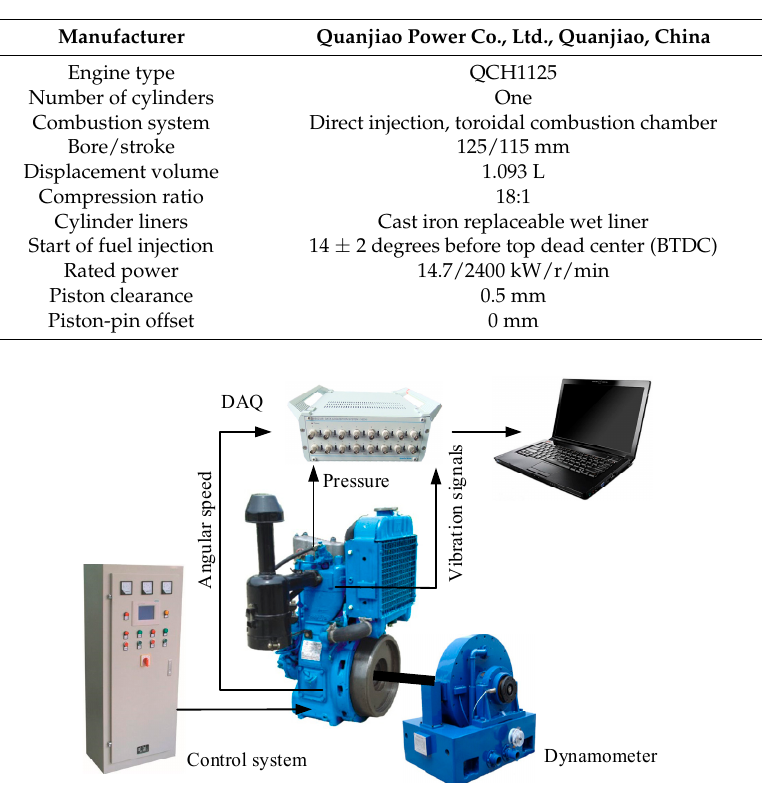
Table 4. Specification of the test engine.